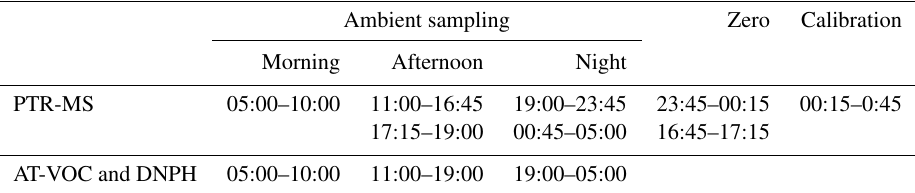
Table 1. Ambient sampling times from SPS 2 for the PTR-MS, AT-VOC and DNPH–HPLC methods; zero and calibration times for the PTR-MS.